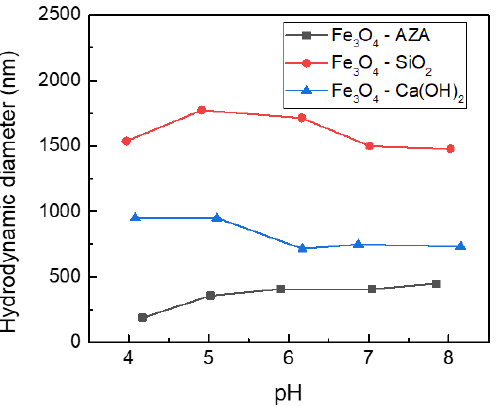
Figure 6. DLS measurement of Fe 3 O 4 -AZA, Fe 3 O 4 -SiO 2 , Fe 3 O 4 -Ca(OH) 2 at different pHs.